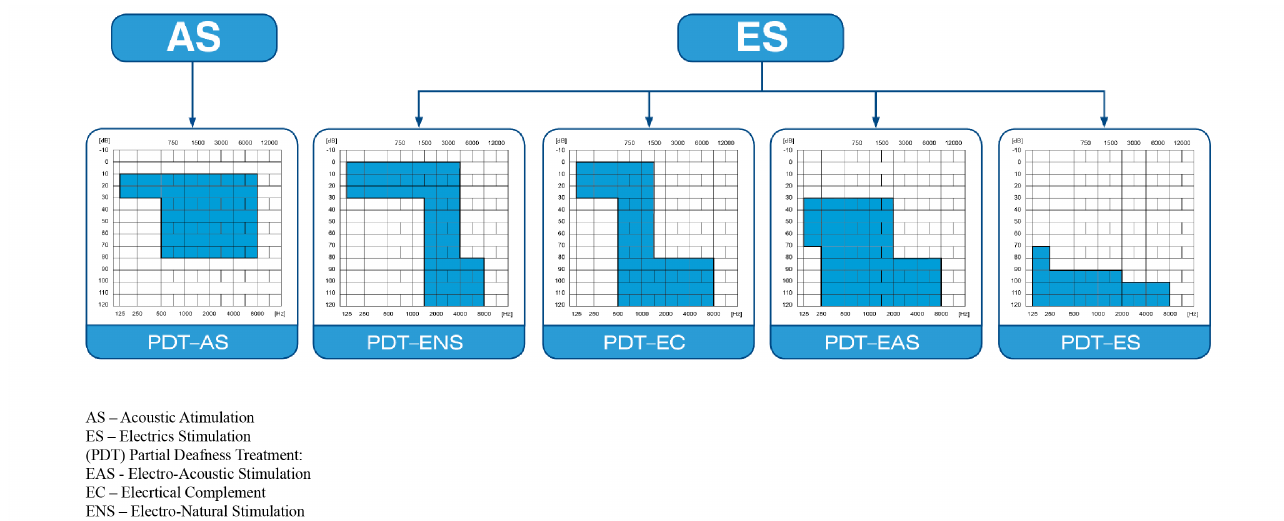
FIGURE 1 - Partial deafness treatment groups for cochlear implantation. ENS: electro-natural stimulation; EC: electrical complement; EAS: electrical-acoustic stimulation; ES: electrical